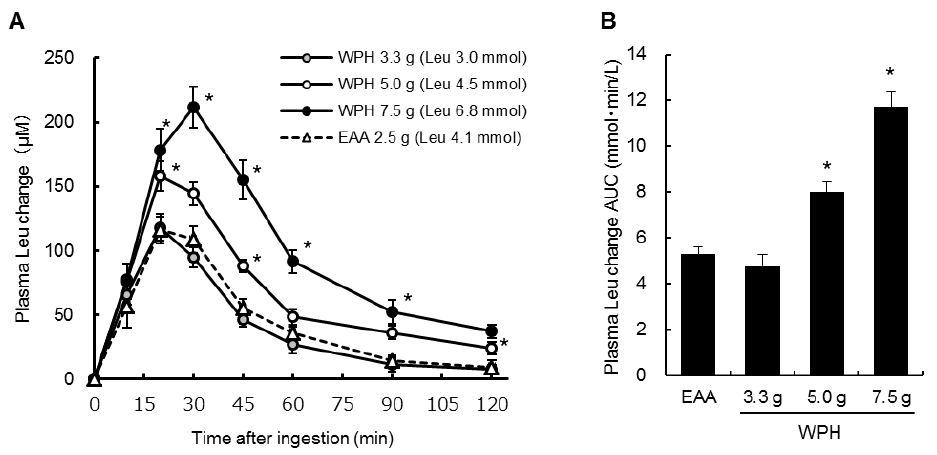
Figure 1. Plasma EAA concentration ( A ) changes from baseline and ( B ) AUCs. Values are mean ± standard error of the mean. * Significantly different from EAA, p < 0.05. AUC: area under the curve; WPH: whey protein hydrolysate; EAA: essential amino acids.